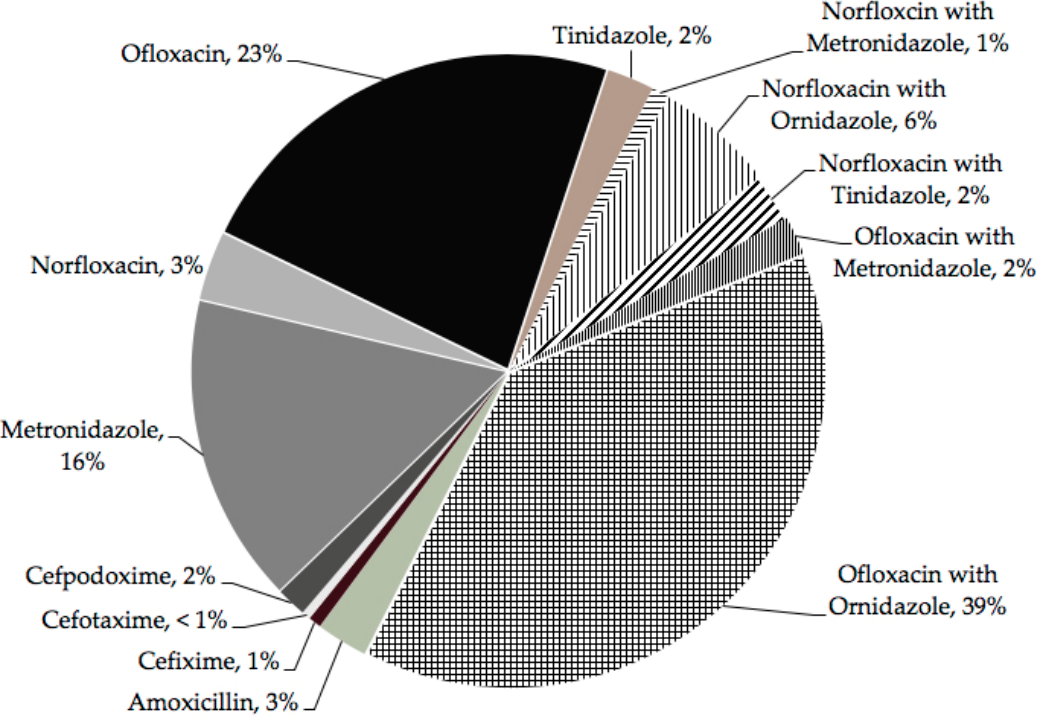
Figure 3. Antibiotics prescribed to the children with diarrhea during the last episode of diarrhea.